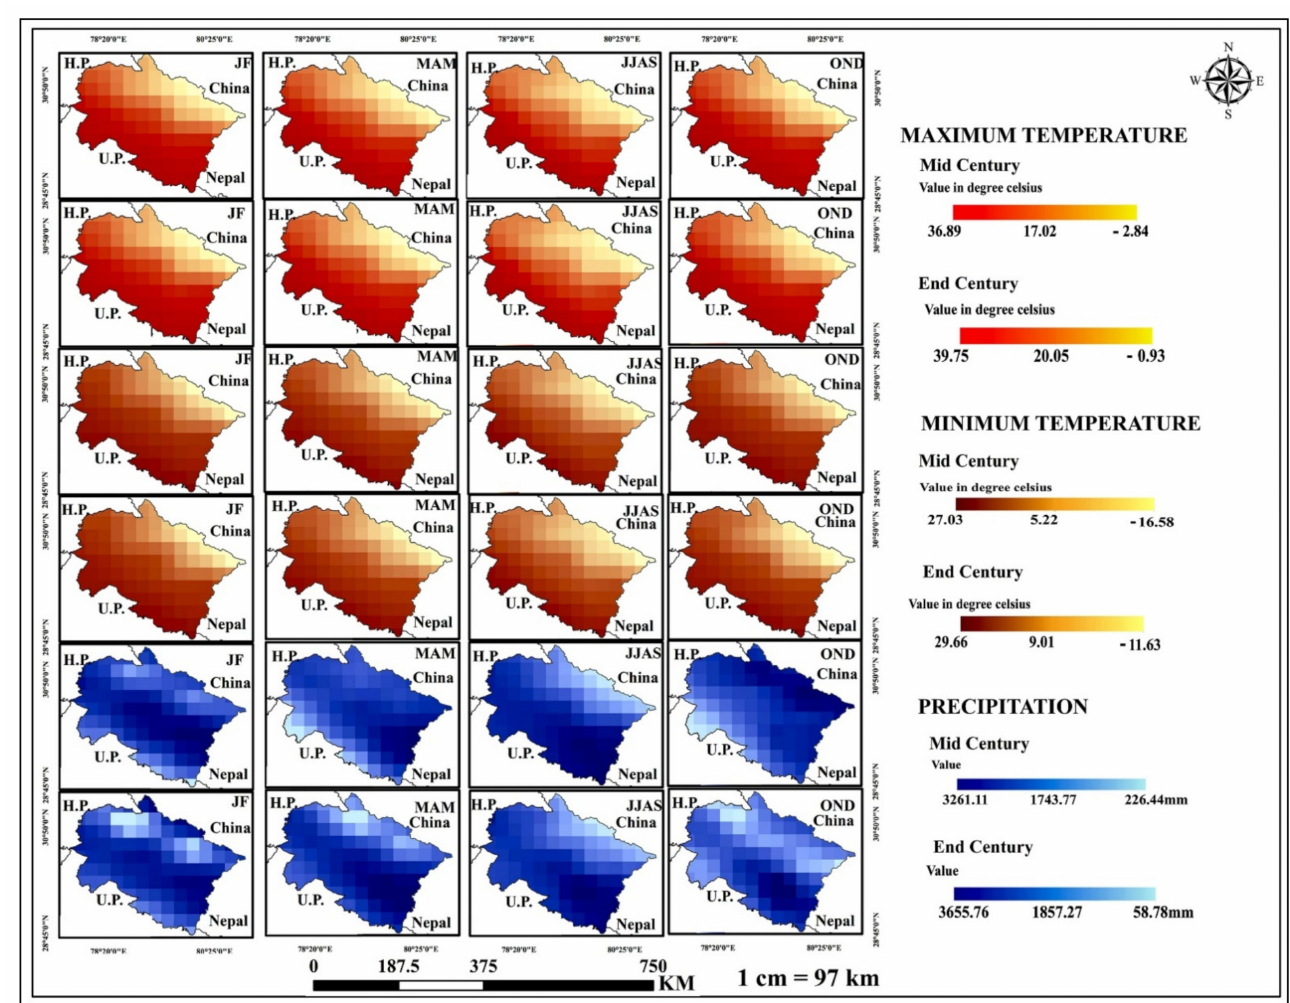
Figure 7. Projected spatial representation of seasonal (JF, MAM, JJAS, and OND) precipitation and